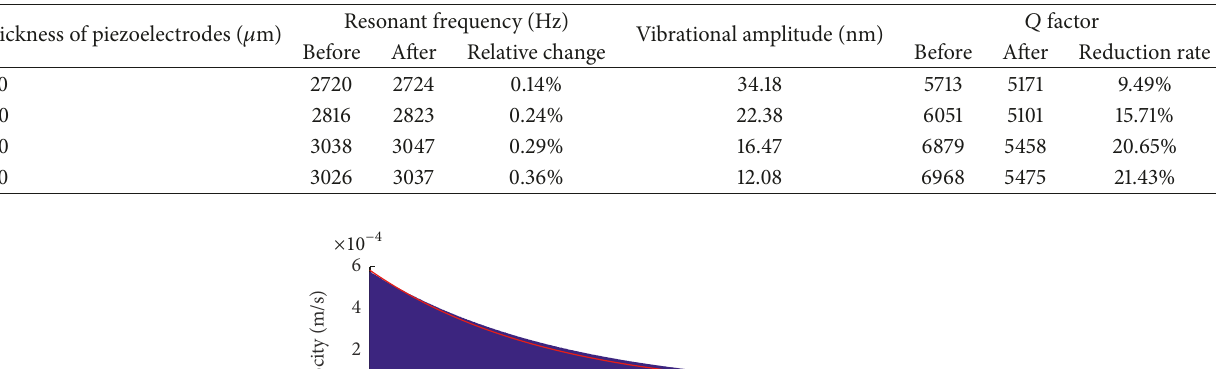
Table 4: The comparison of experimental results between before and after the piezoelectrodes were attached.